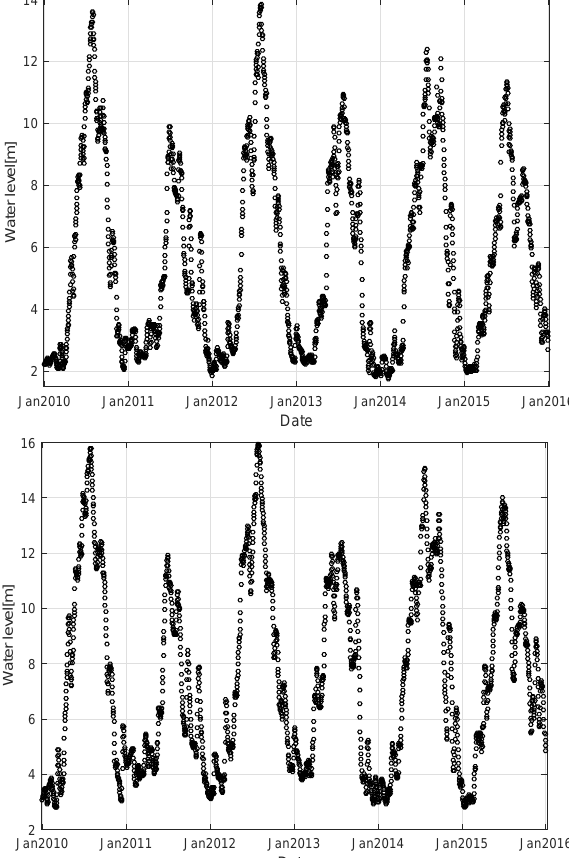
Figure 2. Temporal variation of daily water level at Jianli station (top panel) and Chenglingji station (bottom panel).